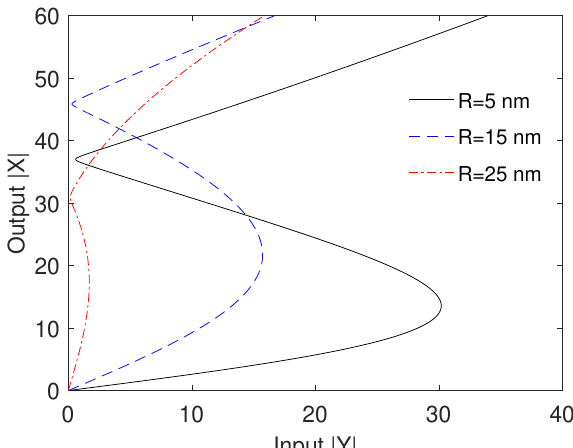
Figure 5. Output versus input for different values of the edge-to-edge distances between MNP and GND. The other parameters are C = 195.34 and the mobility of GND is µ = 10 4 cm 2 V − 1 s − 1 .